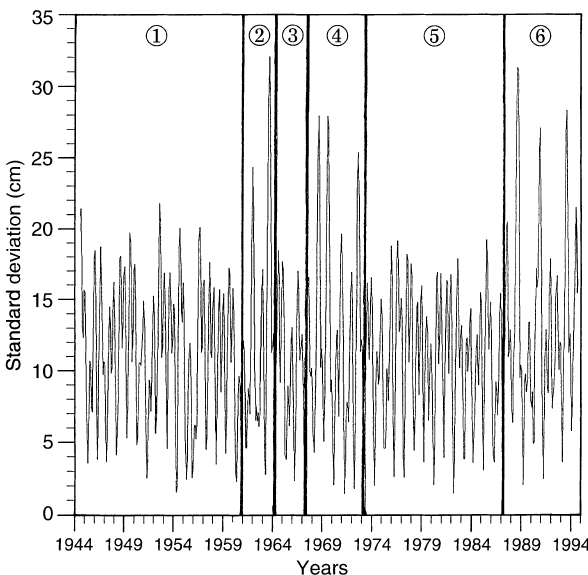
Fig. 11. Six monthly moving averages of the standard deviation